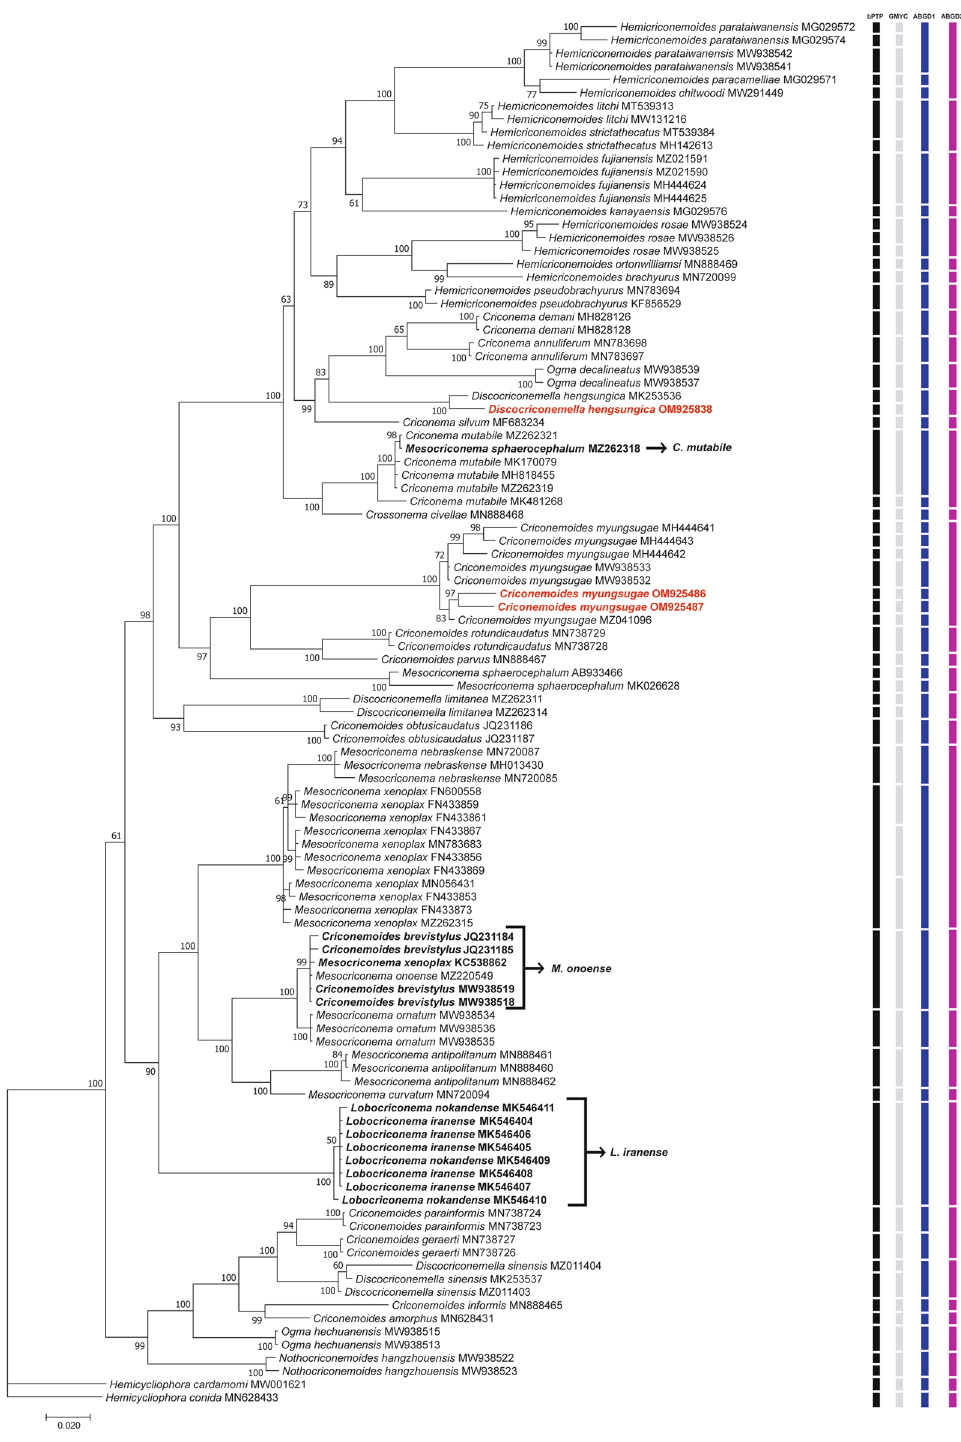
Figure 3. Phylogenetic tree generated from D2-D3 of 28S rRNA sequences under GTR + G + I model. Posterior probability (in percentage) was given next to each node. Sequences of nematode populations from Vietnam were marked by red